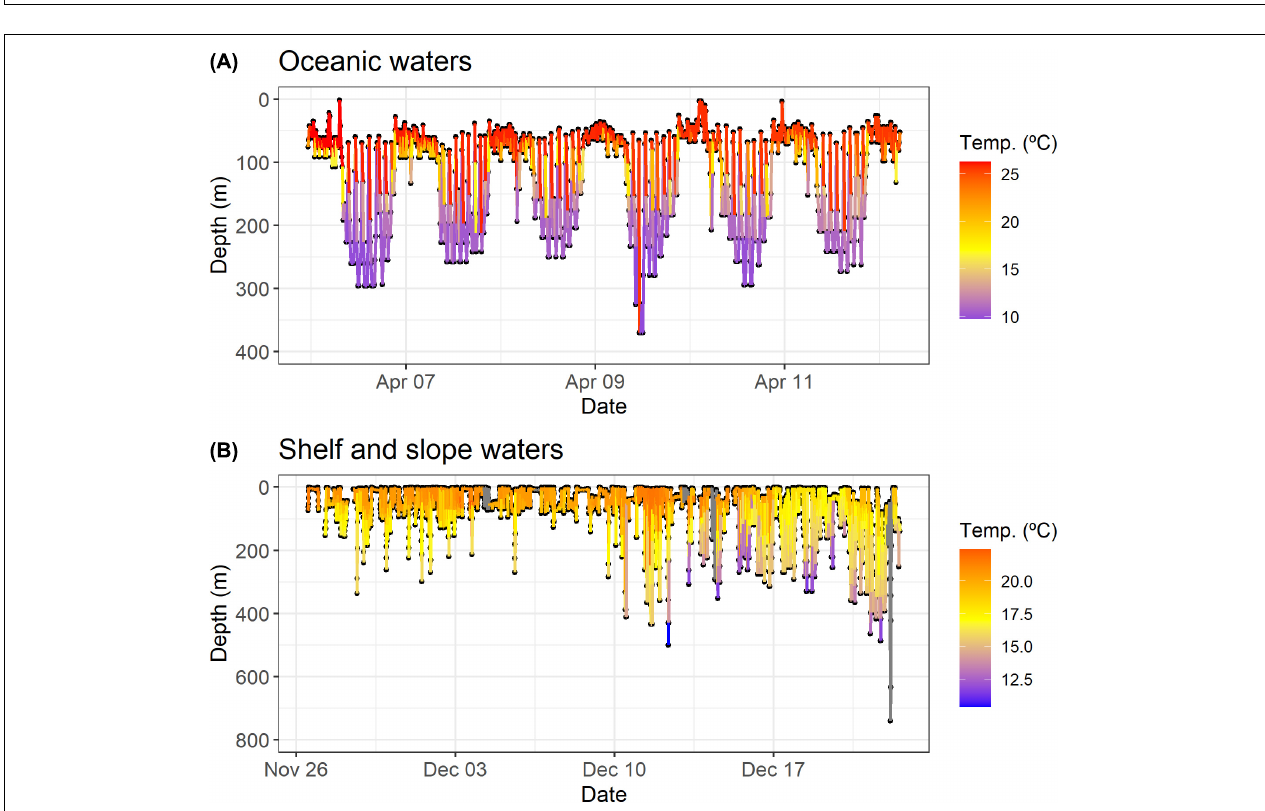
FIGURE 11 | Details of diving behavior profiles of shortfin makos. The plot on the top (A) (shark with tag ID 169528) represents the diel vertical behavior. The plot on the bottom (B) (shark with tag ID 52925) shows the oscillatory diving (yo-yo diving) behavior, with occasional deep dives.